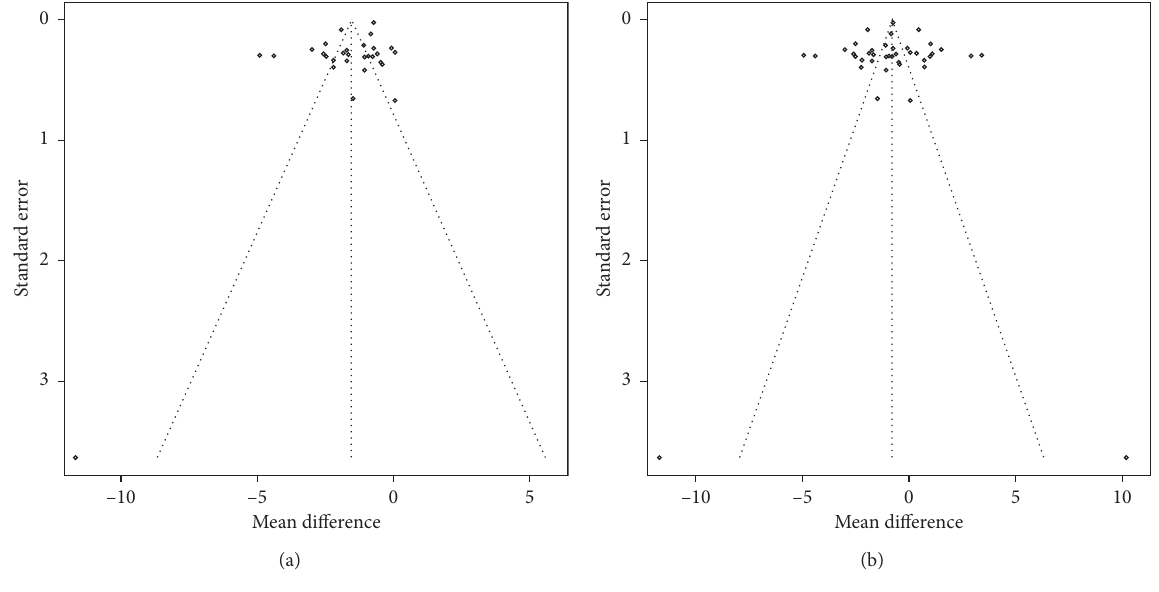
Figure 10: The funnel plots of